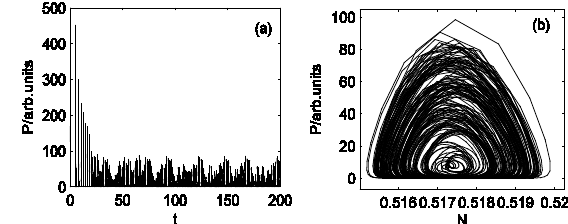
Fig. 10. Chaos. (a) a chaotic movement. (b) a chaotic attractor.